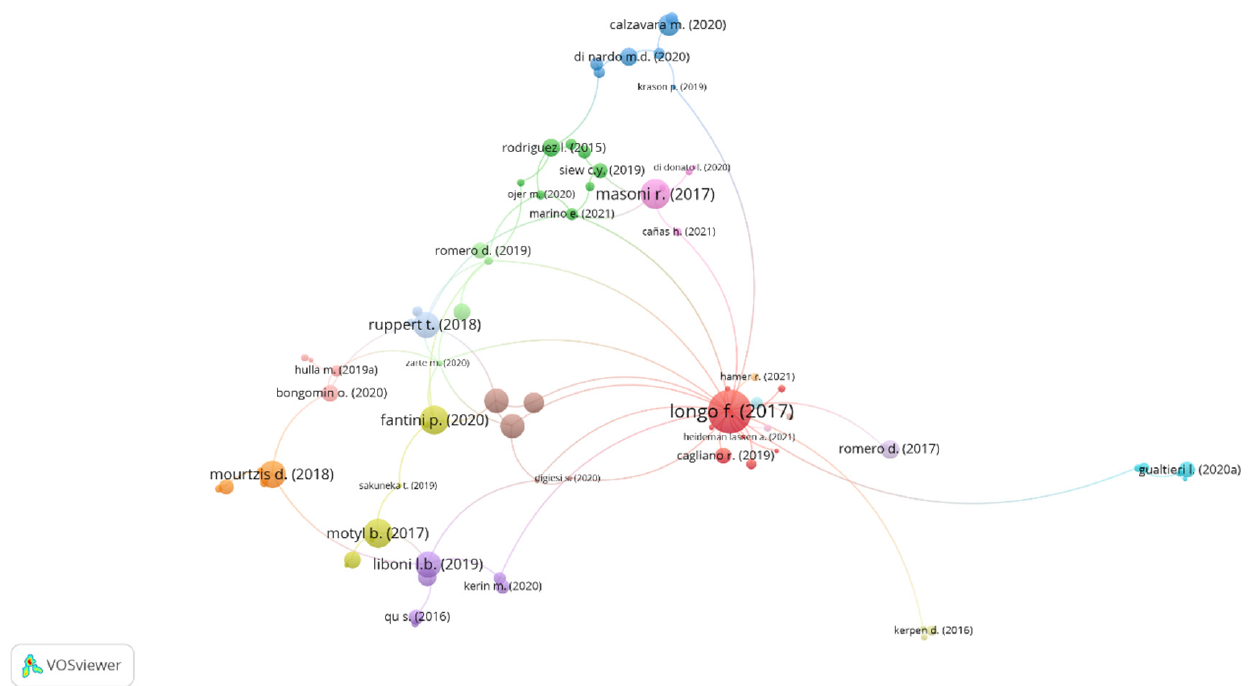
Figure 1. The most connected documents of the database by citations. Source: based on Scopus database edited by authors. Table 2. A model for Industry 4.0